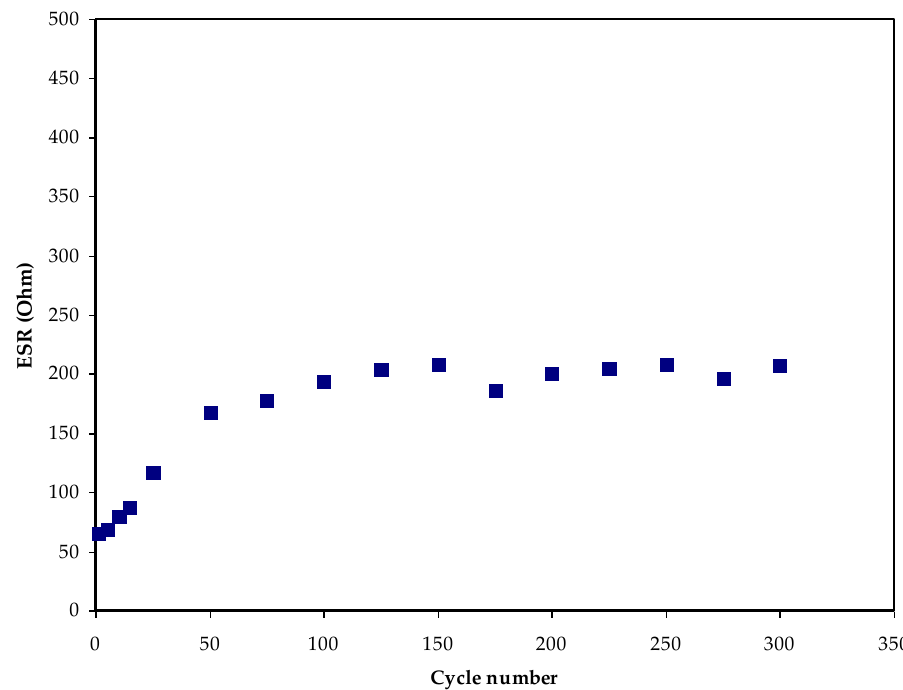
Figure 6. EDLC specific capacitance outcome over 300 cycles.